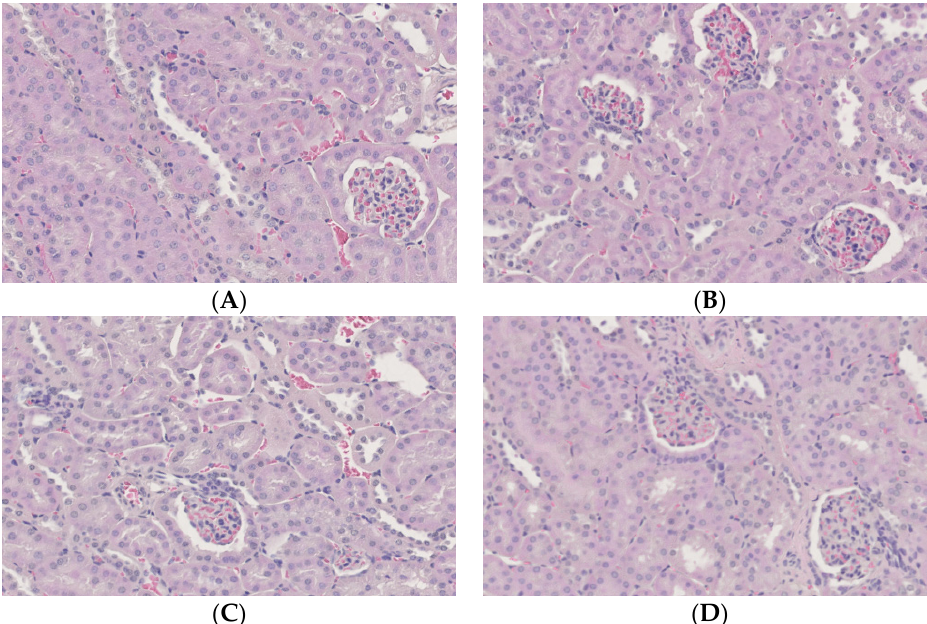
Figure 7. Histopathological changes in the kidneys of mice. ( A ) C, control group; ( B ) CD/RALA, R-